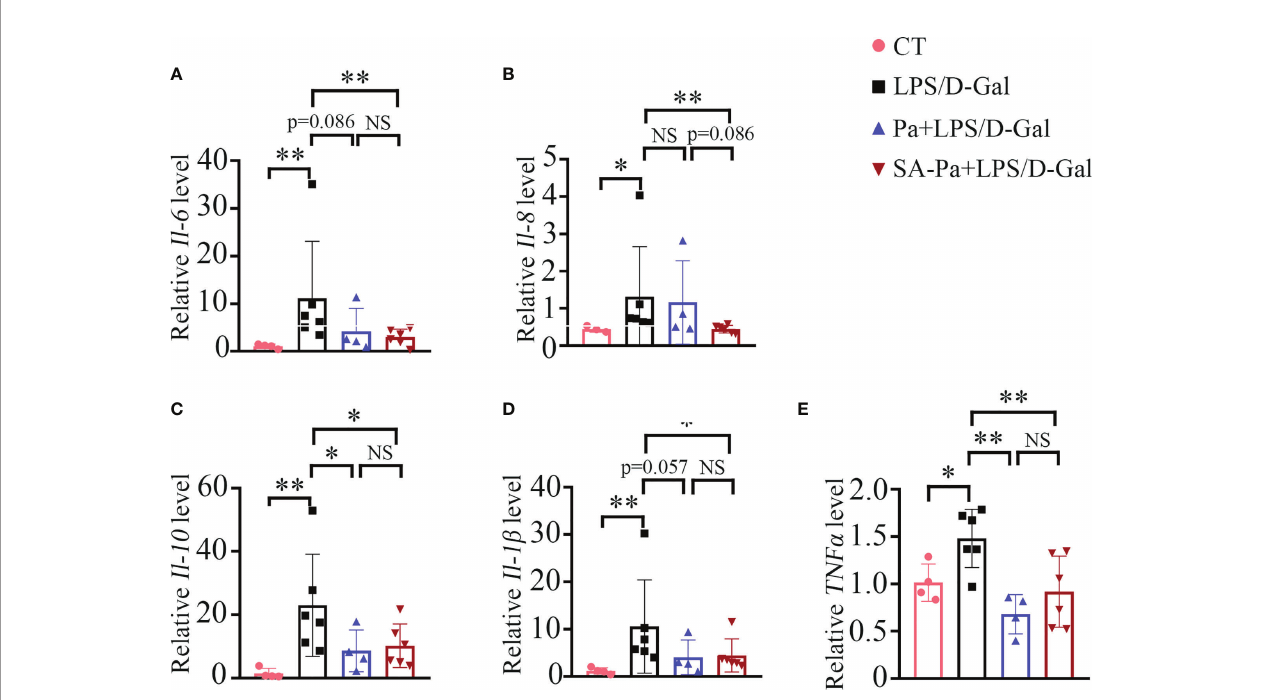
FIGURE 3 | SA-Pa inhibited the transcriptional levels of in fl ammatory cytokines after the LPS/D-Gal injury. (A – E) qPCR results of the indicated genes in the liver of different groups (CT group, n = 3-4; LPS/D-Gal group, n = 6; Pa group, n = 4; SA-Pa group, n = 6; NS p > 0.05; *p < 0.05; **p <